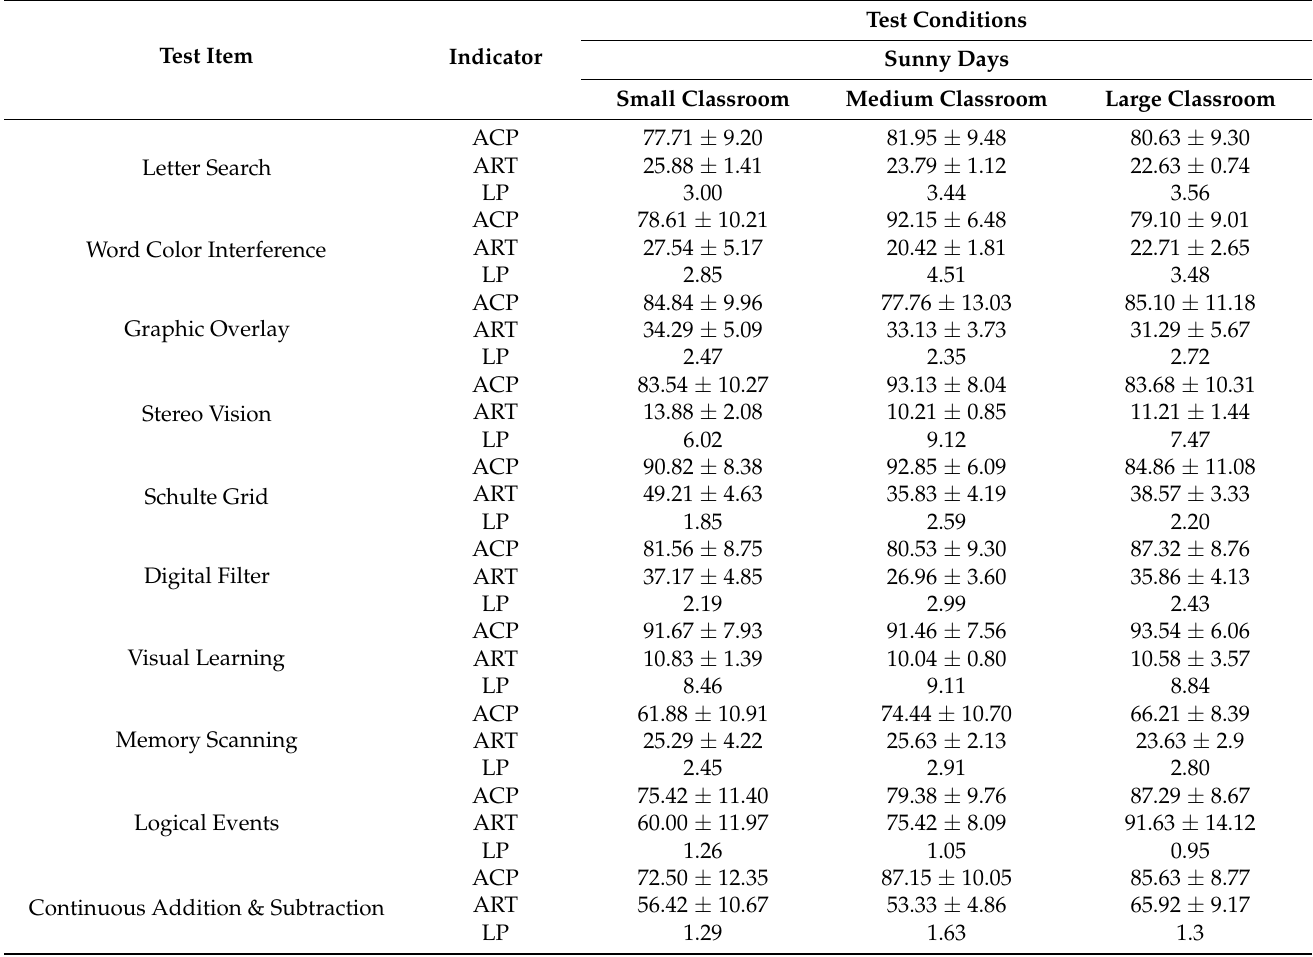
Table A3. The final results of the ACP, ART and LP of the relevant test items on rainy